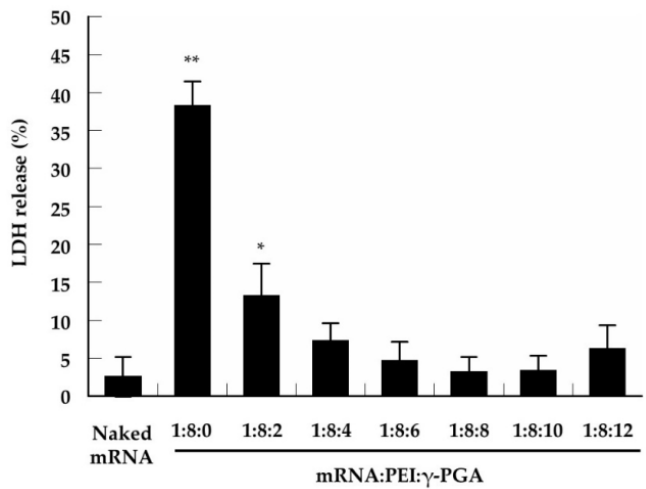
Figure 4. Cytotoxicity of the mRNA/PEI8 complex and the mRNA/PEI8/ γ -PGA complexes at various charge ratios (1:8:2, 1:8:4, 1:8:6, 1:8:8, 1:8:10, and 1:8:12). Cytotoxicity was based on lactate dehydrogenase (LDH) release from B16 cells treated with each complex. Cells were incubated with the complexes for 2 h before the measurement of LDH in the culture medium. Data represent the mean ± S.E. ( n = 8). * p < 0.05, ** p < 0.01 vs. naked